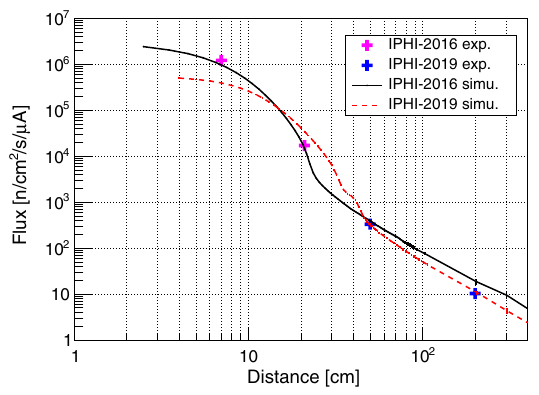
Figure 2: Thermal neutron flux (E n < 400 meV) as a func- tion of the distance (see Figure 1), for the 2016 and 2019 TMR configurations. Geant4 simulation results are com- pared with experimental